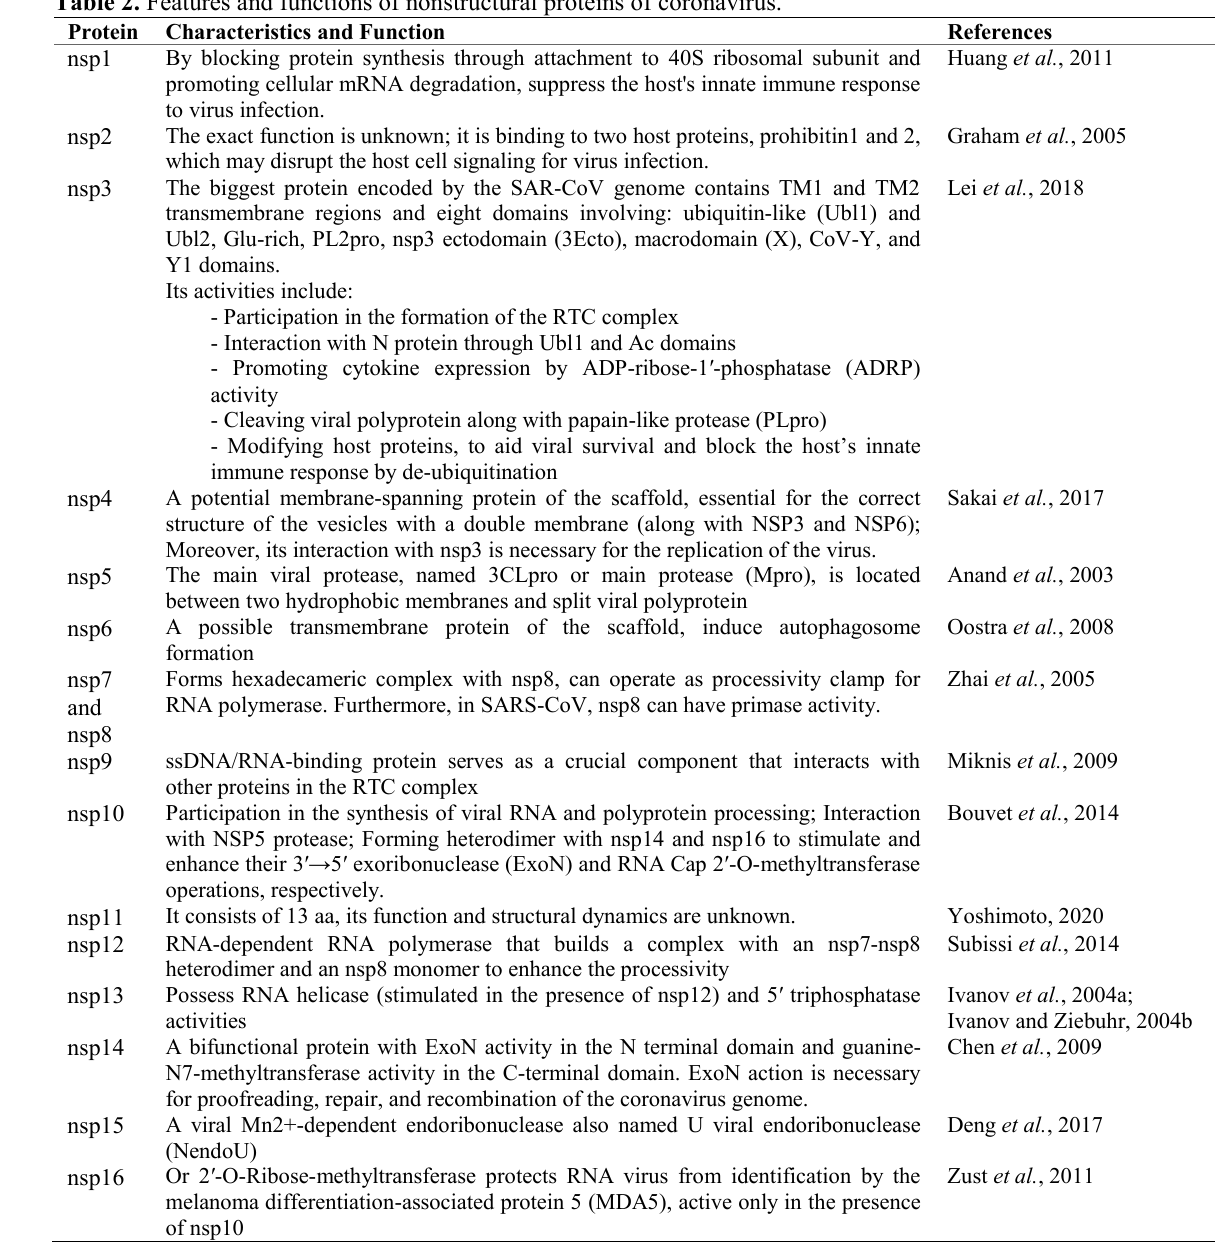
Table 2. Features and functions of nonstructural proteins of coronavirus. Protein Characteristics and